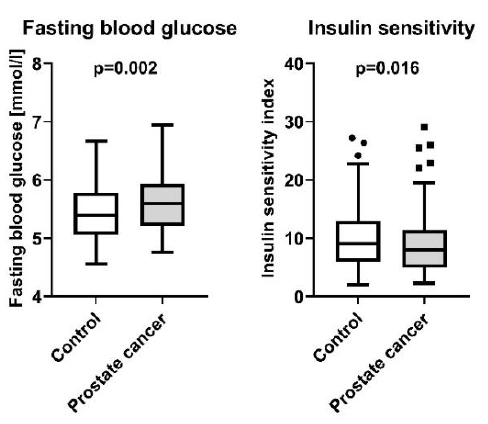
Figure 1. Fasting blood glucose and insulin sensitivity index in 103 patients with newly diagnosed and yet untreated PCa, and 107 male controls without PCa from the Tübingen Family Study. Presented are box plots with whiskers indicating 1.5 interquartile range. Table 1. Characteristics of the study population. Included are 103 patients with newly diagnosed and yet untreated PCa, and 107 male controls without PCa from the Tübingen Family Study. Abbreviations: AUC, area under the curve; BMI, body mass index. Data are given as mean ± SEM for all parameters. p -values are given for unadjusted data, p *-values are for a model adjusting for age and BMI, except the associations with insulin secretion which are adjusted for age and insulin sensitivity.